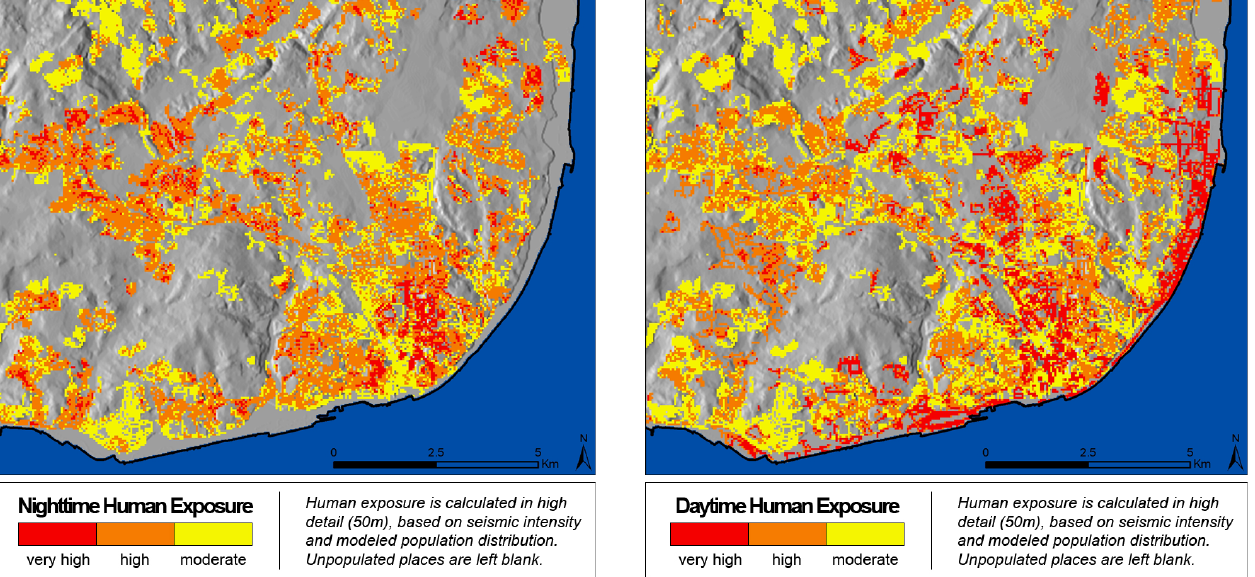
Fig. 7. Map of daytime human exposure to seismic hazard centered in the city of Lisbon (terrain hillshade used as